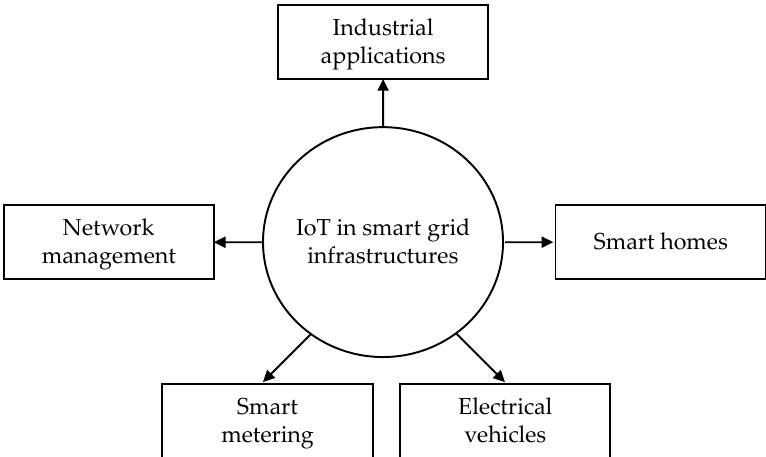
Figure 1. Examples of smart grids’ applications based on the Internet of Things (IoT) technology.